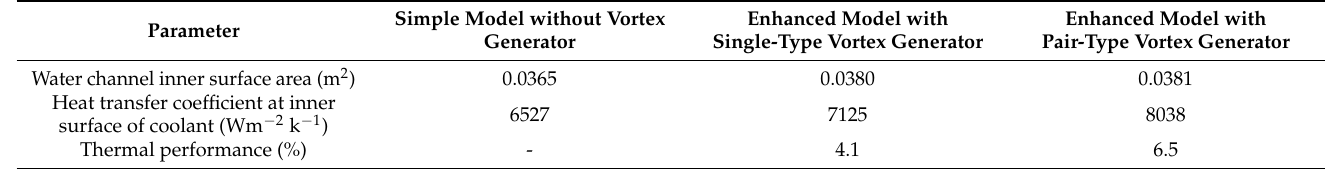
Figure 8. Temperature contour of enhanced models with each type of vortex generator: ( a ) Single-type vortex generator; ( b ) pair-type vortex generator. Table 5. Comparison of the thermal performance of the simple and enhanced